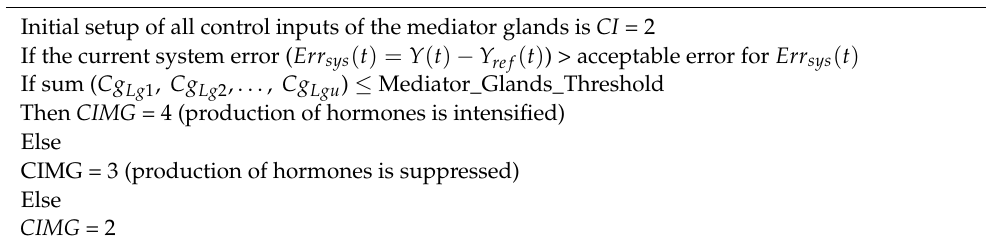
Algorithms 1 Control input selection